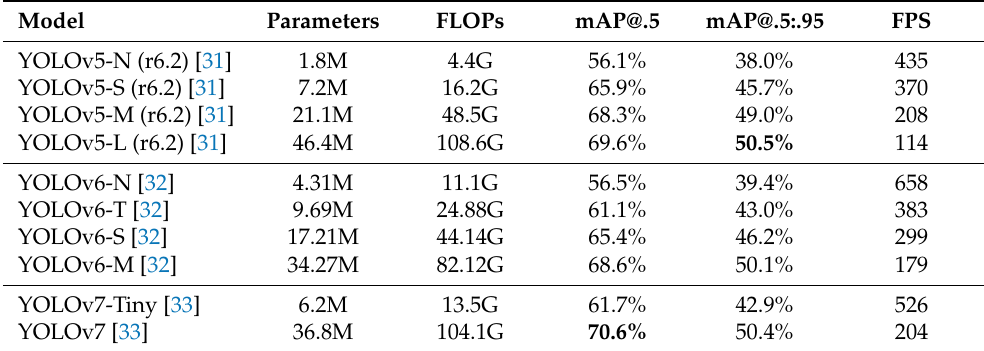
Table 2. Comparison of detection results on algal